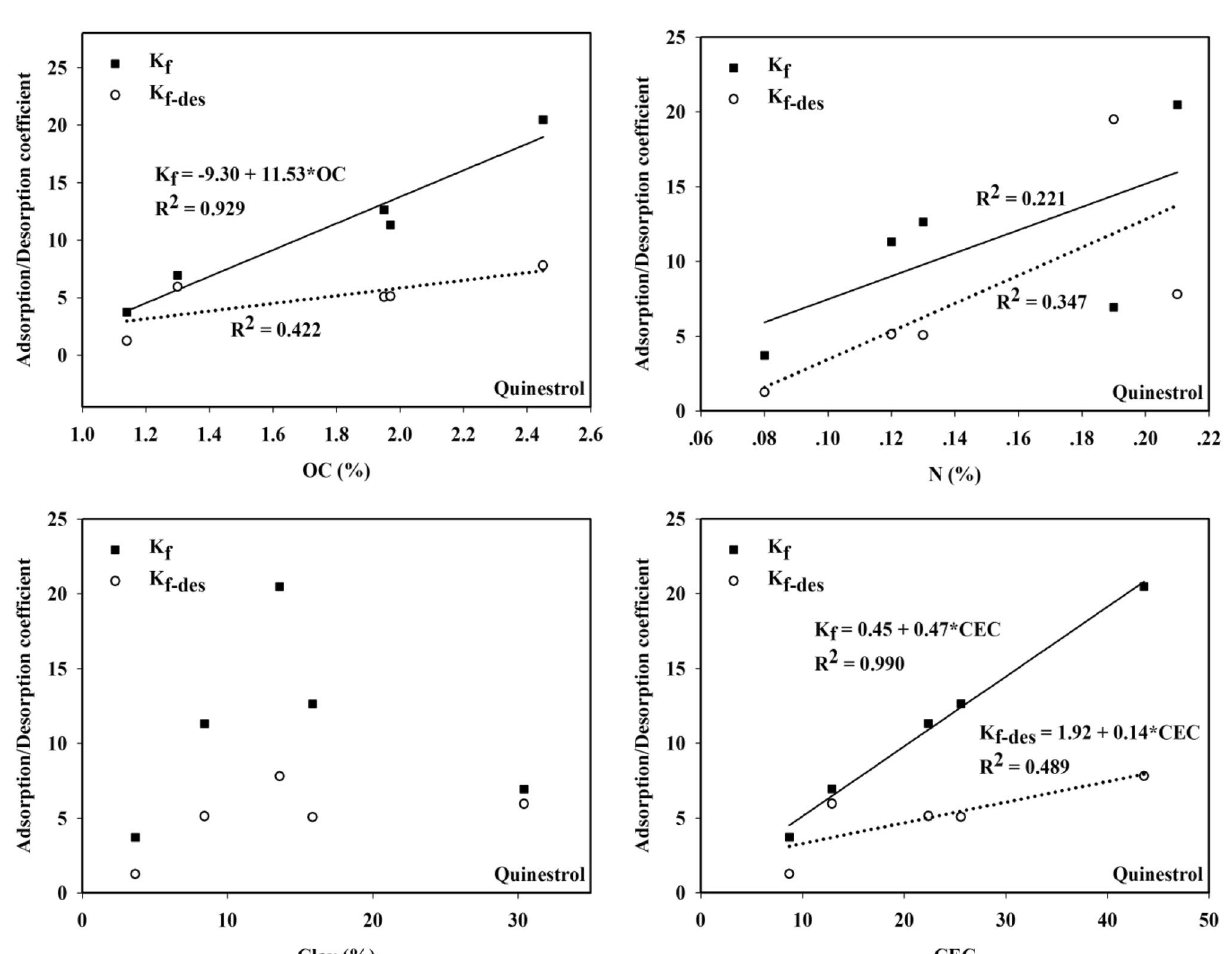
Figure 3. Correlations between K f /K fdes and parameters of soil for